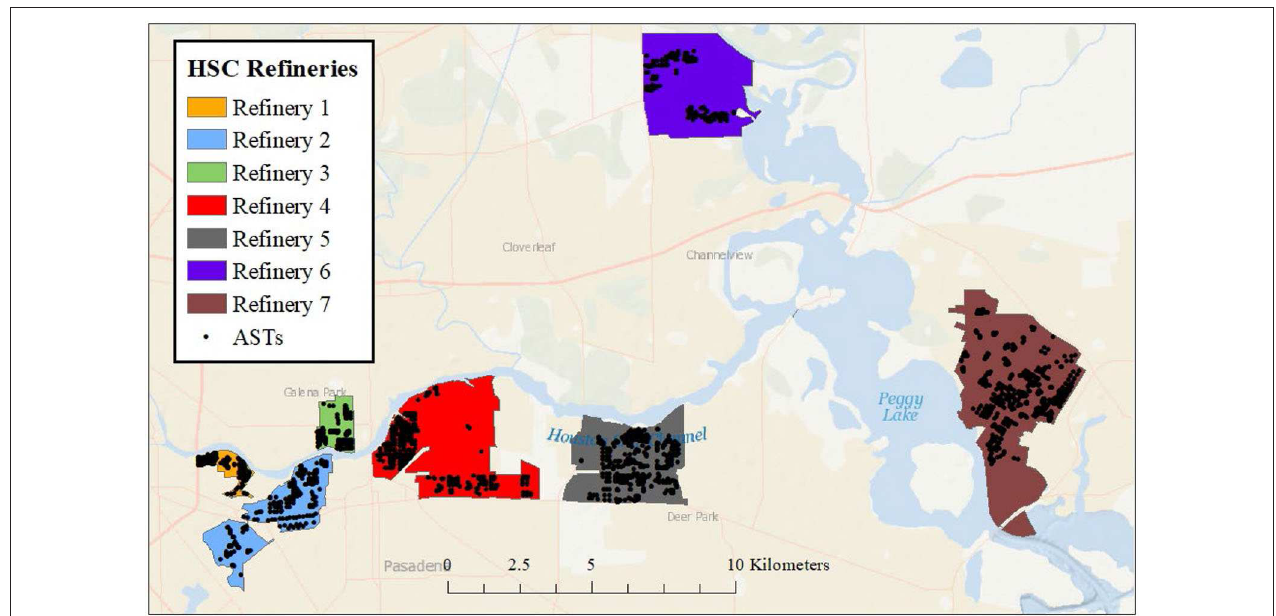
FIGURE 2 | Refineries and ASTs in the HSC area considered in the case